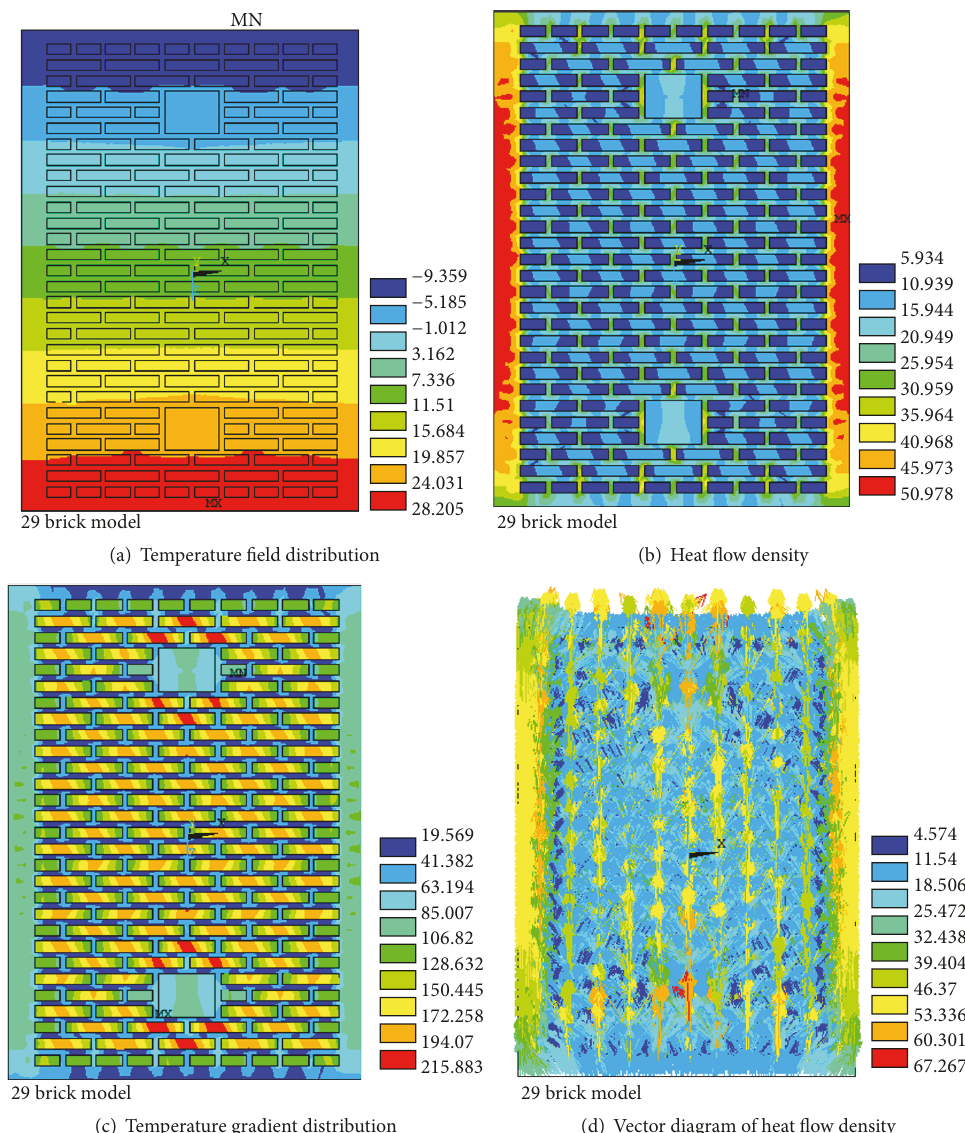
Figure 11: Simulation results for the hollow shale